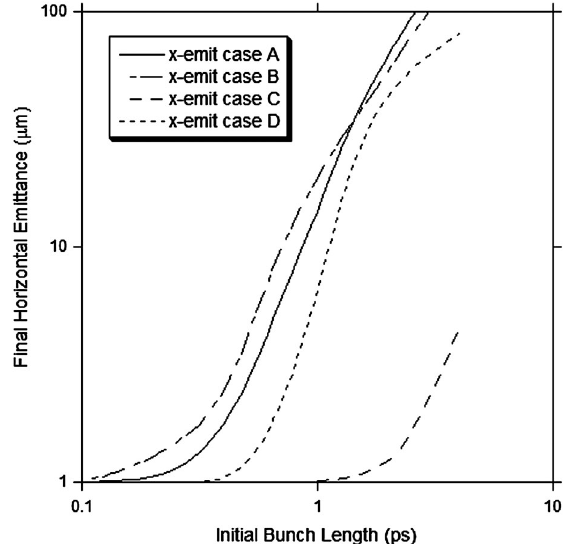
FIG. 4. Final horizontal emittance versus initial bunch length for cases A through D. Case C has the best performance, with final emittances of 1.10, 1.19, and 4 : 94 (cid:3) m for bunch lengths of 1, 2, and 4 ps, respectively. Final bunch lengths for all cases was very nearly 25 fsec.